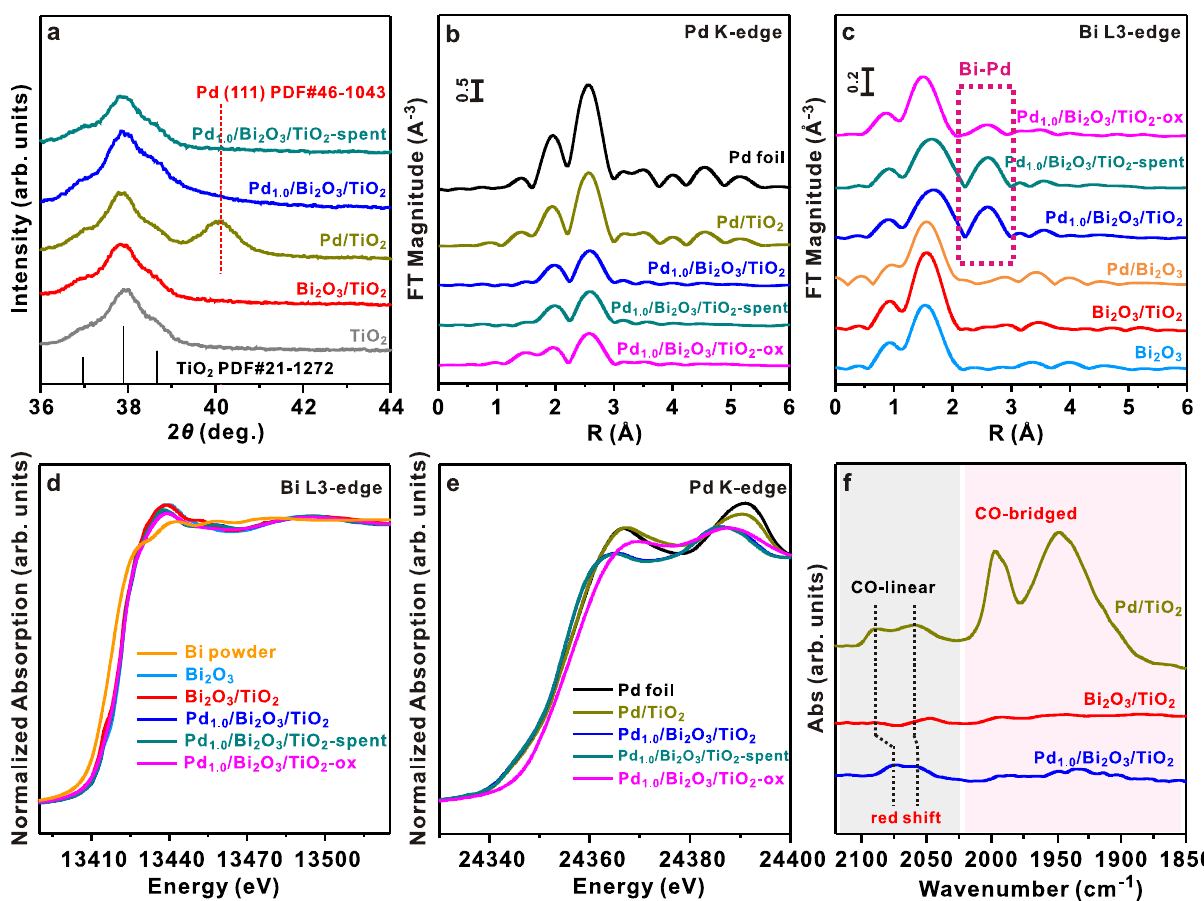
Fig. 2 Characterization of Pd 1.0 /Bi 2 O 3 /TiO 2 . a XRD patterns of TiO 2 , Pd/TiO 2 , Bi 2 O 3 /TiO 2 , and Pd 1.0 /Bi 2 O 3 /TiO 2 ; b Fourier transform spectra of Pd K - edge EXAFS for Pd/TiO 2 , Pd 1.0 /Bi 2 O 3 /TiO 2 , and oxidized Pd 1.0 /Bi 2 O 3 /TiO 2 (Pd 1.0 /Bi 2 O 3 /TiO 2 -ox); c Fourier transform spectra of Bi L3-edge EXAFS; d Bi L3-edge XANES spectra for Bi 2 O 3 /TiO 2 , Pd 1.0 /Bi 2 O 3 /TiO 2 , and Pd 1.0 /Bi 2 O 3 /TiO 2 -ox. Bi and Bi 2 O 3 powder were used as references. e Pd K -edge XANES spectra for